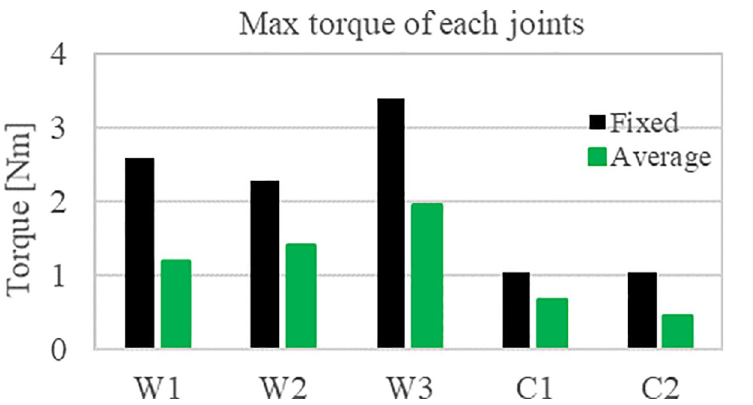
Fig 14. Comparison of the maximum torque applied to the joint during valve operation.